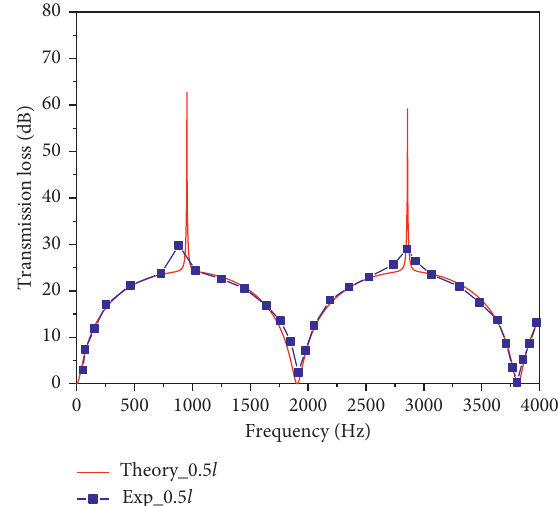
Figure 15: Comparison of the theoretical and experimental results of the transmission loss of the muffler (0.5 l ).